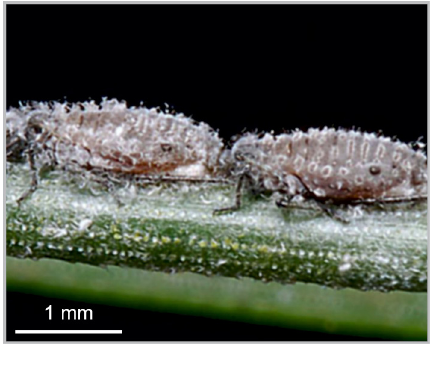
Fig. 86. Schizolachnus obscurus Börner, 1940. Aptera on Pinus nigra (from Dransfield & Brightwell 2015, licensed under Creative Commons Attribution 3.0, downloaded 2 Mar. 2016).